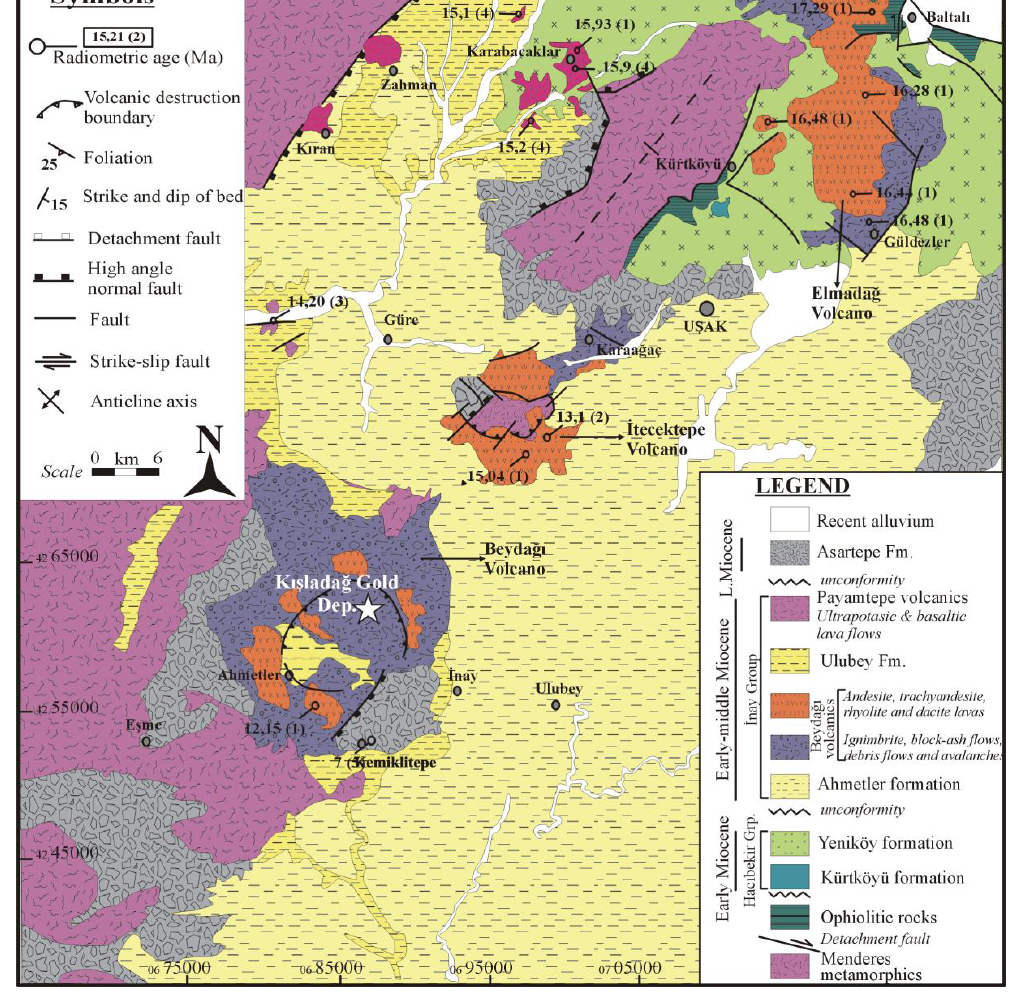
Figure 2. Geological map of the Uşak area [11] and location of the Kışladağ gold deposit.